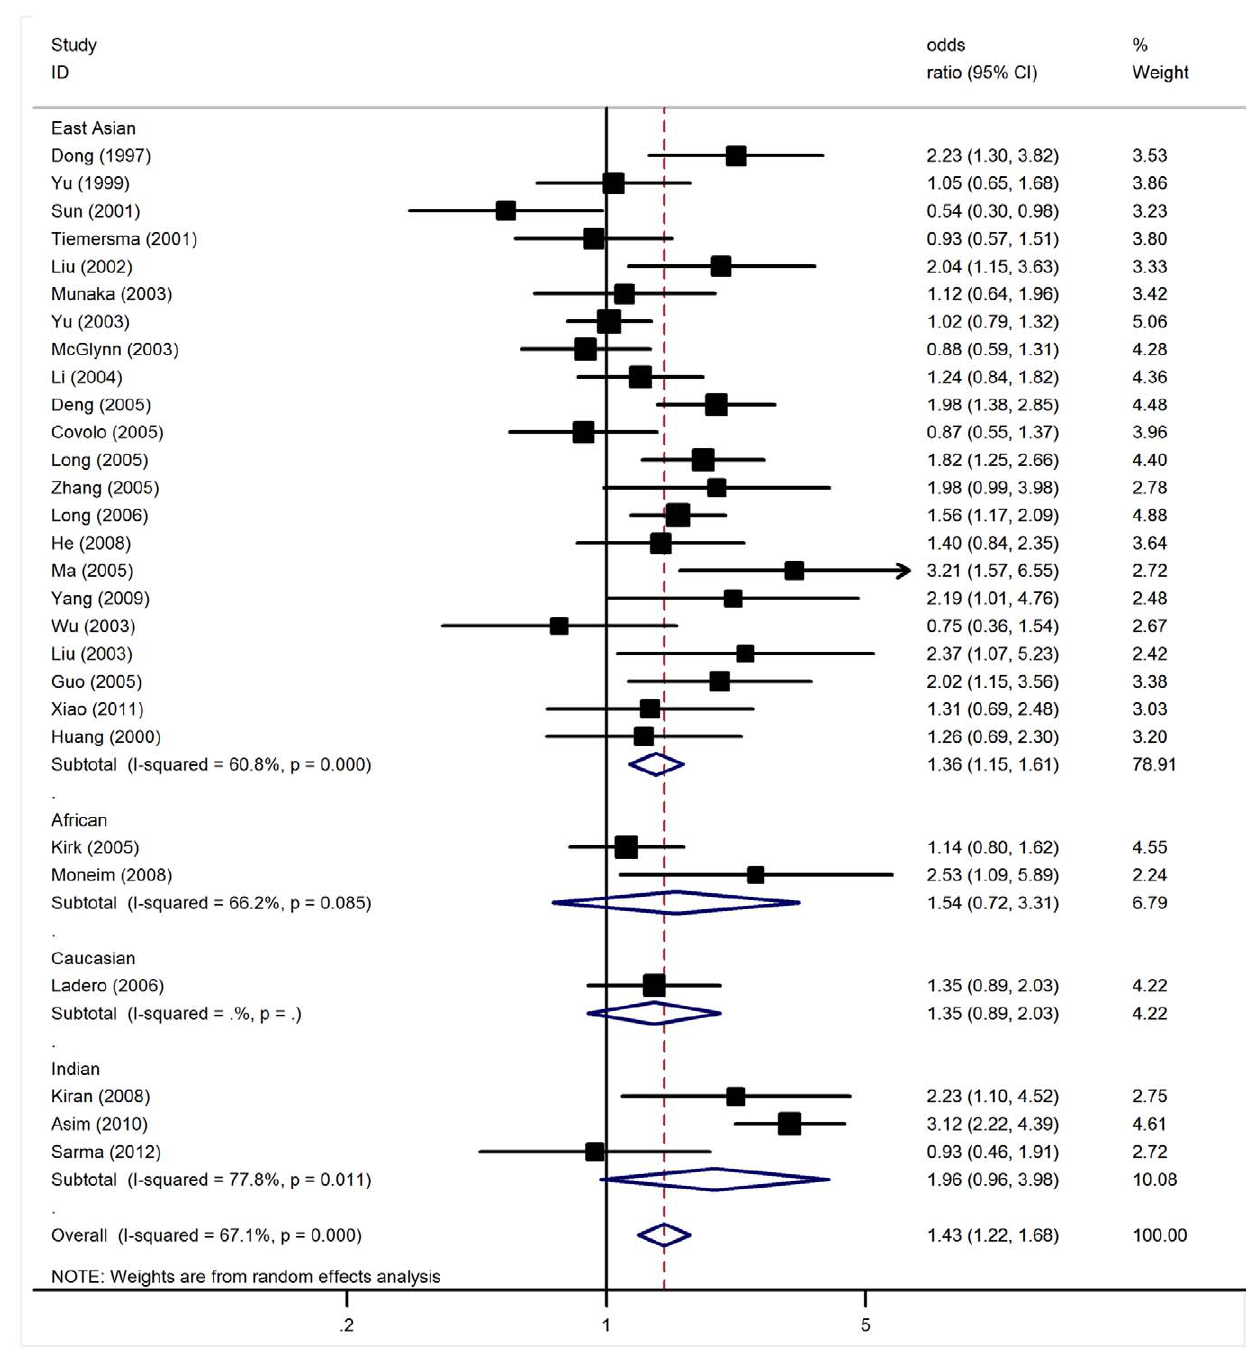
Figure 2. Meta-analysis of GSTT1 null genotype associated with HCC.